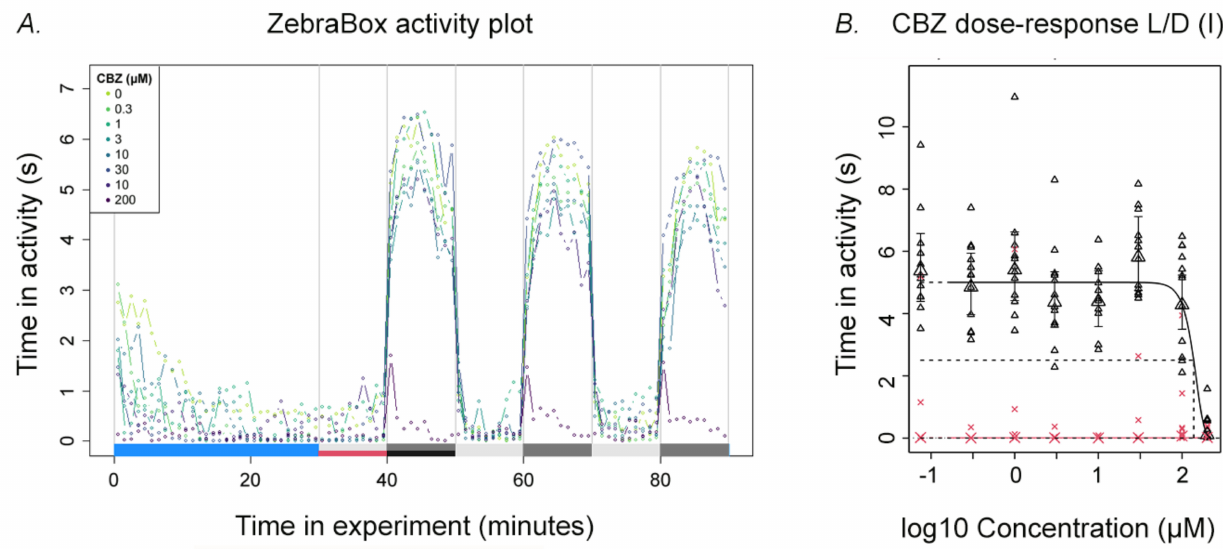
Figure 1. ( A ) A plot overview showing the entire light-dark transition test applied for the CBZ experiment, after 0–120-hpf exposure. The blue horizontal bar indicates the acclimatization period, while the grey and black bars represent the light and dark period, respectively. The X-axis shows the whole experiment time, whereas the Y-axis shows the time (s) spent in activity within 1 min by the zebrafish embryos ( n = 12). Each dot shows the average time (s) spent in activity by 12 embryos/concentration in 1 min of recording, whereas different colours represent different concentrations shown in the upper left legend. ( B ) A dose–response curve of an individual CBZ experiment. The data set belongs to the first light-dark block of Figure 1A. The red crosses/lines represent the light period, whereas the black triangles/lines represent the dark period. The X-axis shows the CBZ dose range ( µ M) in log scale, whereas the Y-axis shows the time (s) spent in activity within 1 min. Each small symbol shows the time (s) spent in activity by each of the individual 12 replicate embryos within 1 min, while the large symbol represents the geometric means of n = 12 together with their confidence intervals (error